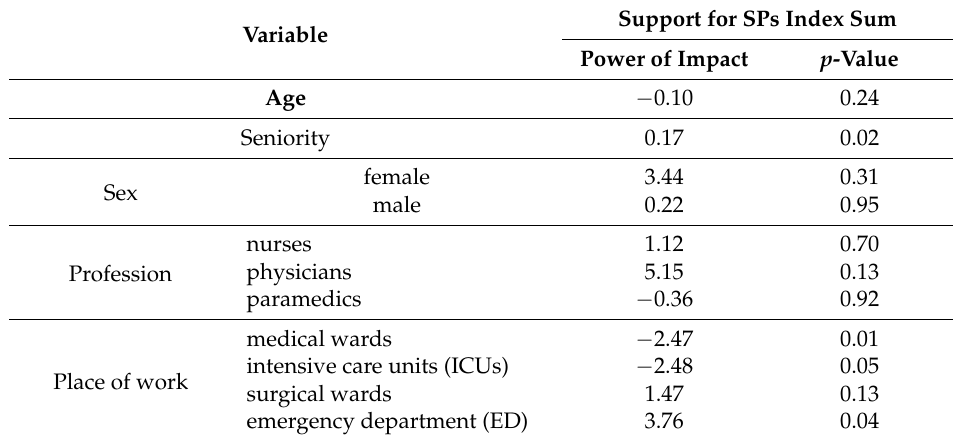
Table 2. Impact of selected measurable descriptors on the support index for SPs (the analysis was conducted using linear regression).